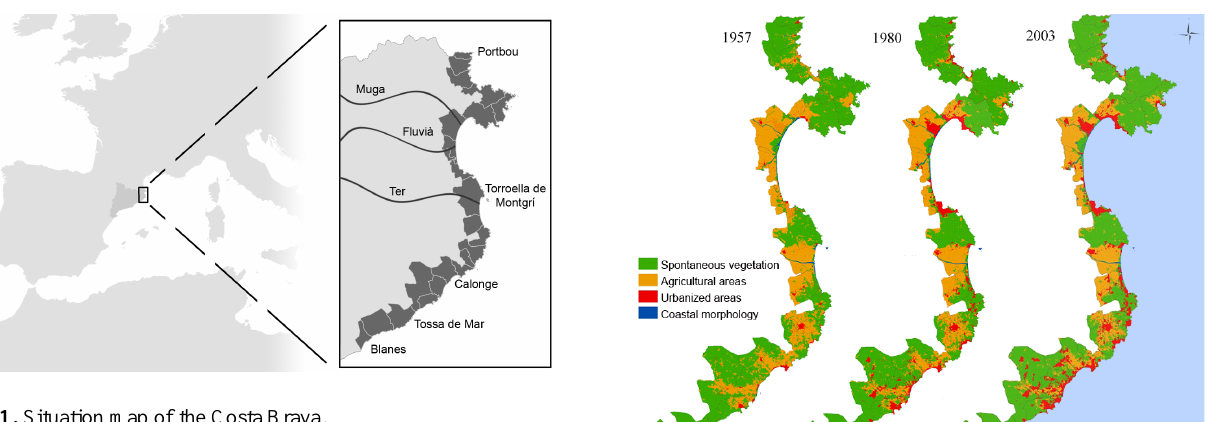
Fig. 1. Situation map of the Costa Brava.